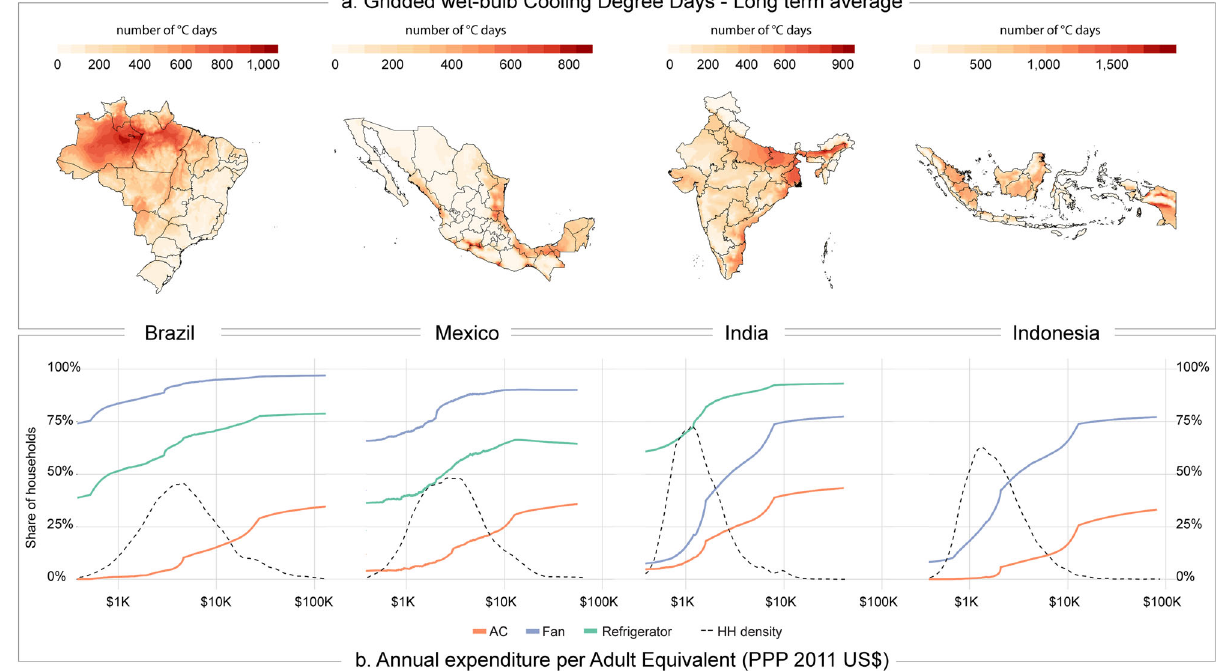
Fig. 1 Climate, air-conditioning, and income characteristics in four selected emerging economies. a A 30-year average of gridded wet-bulb cooling degree days (CDDs), up to the second wave of household data used in the study (2009 for Brazil and 2012 for all other countries). b Rates of air- conditioning (AC) ownership in relation to per capita total expenditure (2011 US constant dollars at PPP) and comparison to other cooling devices in the second wave of household data. The black dashed line shows the distribution of households (HH) across income levels. Maps are generated using the sp, rgdal, and raster R